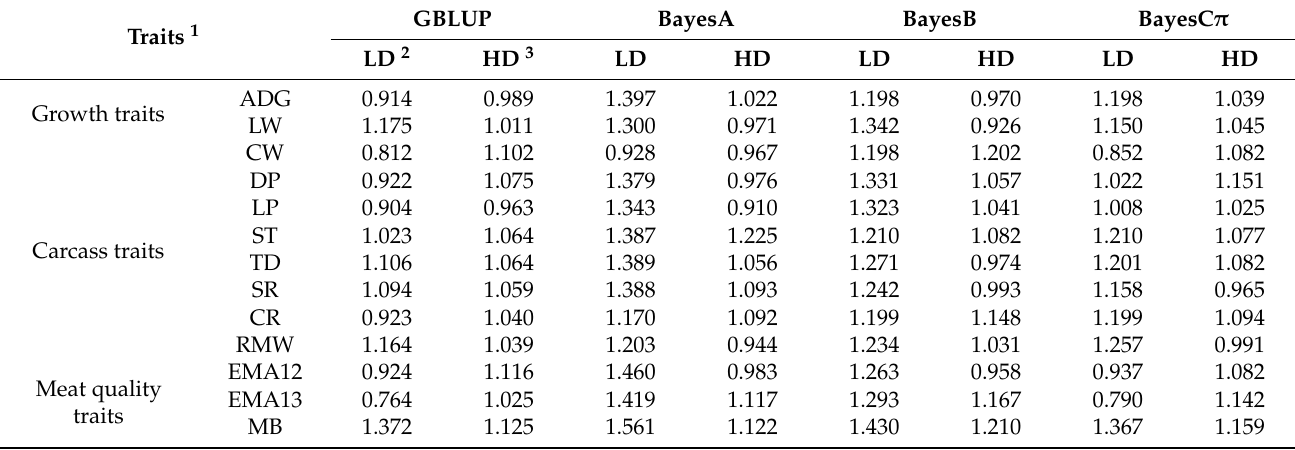
and BayesB in the low-density SNP panel, since the deflation of the DGVs predicted by it was smaller. Table 3. Regression coefficients for GEBVs for the low-density SNP panel using different methods. Traits 1